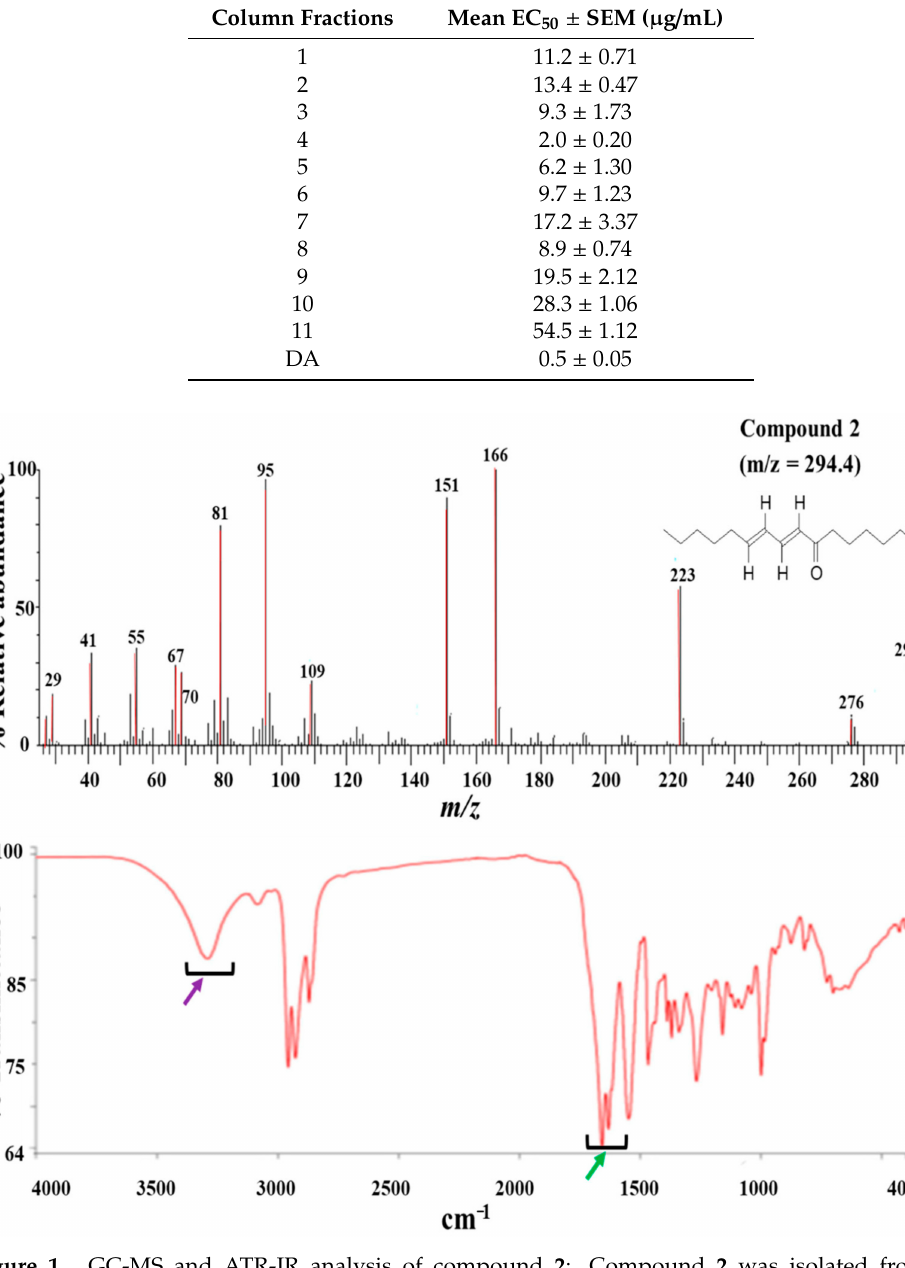
Table 1. Antitrypanosomal activities of chromatographic dichloromethane fractions of Z. zanthoxyloides (root).